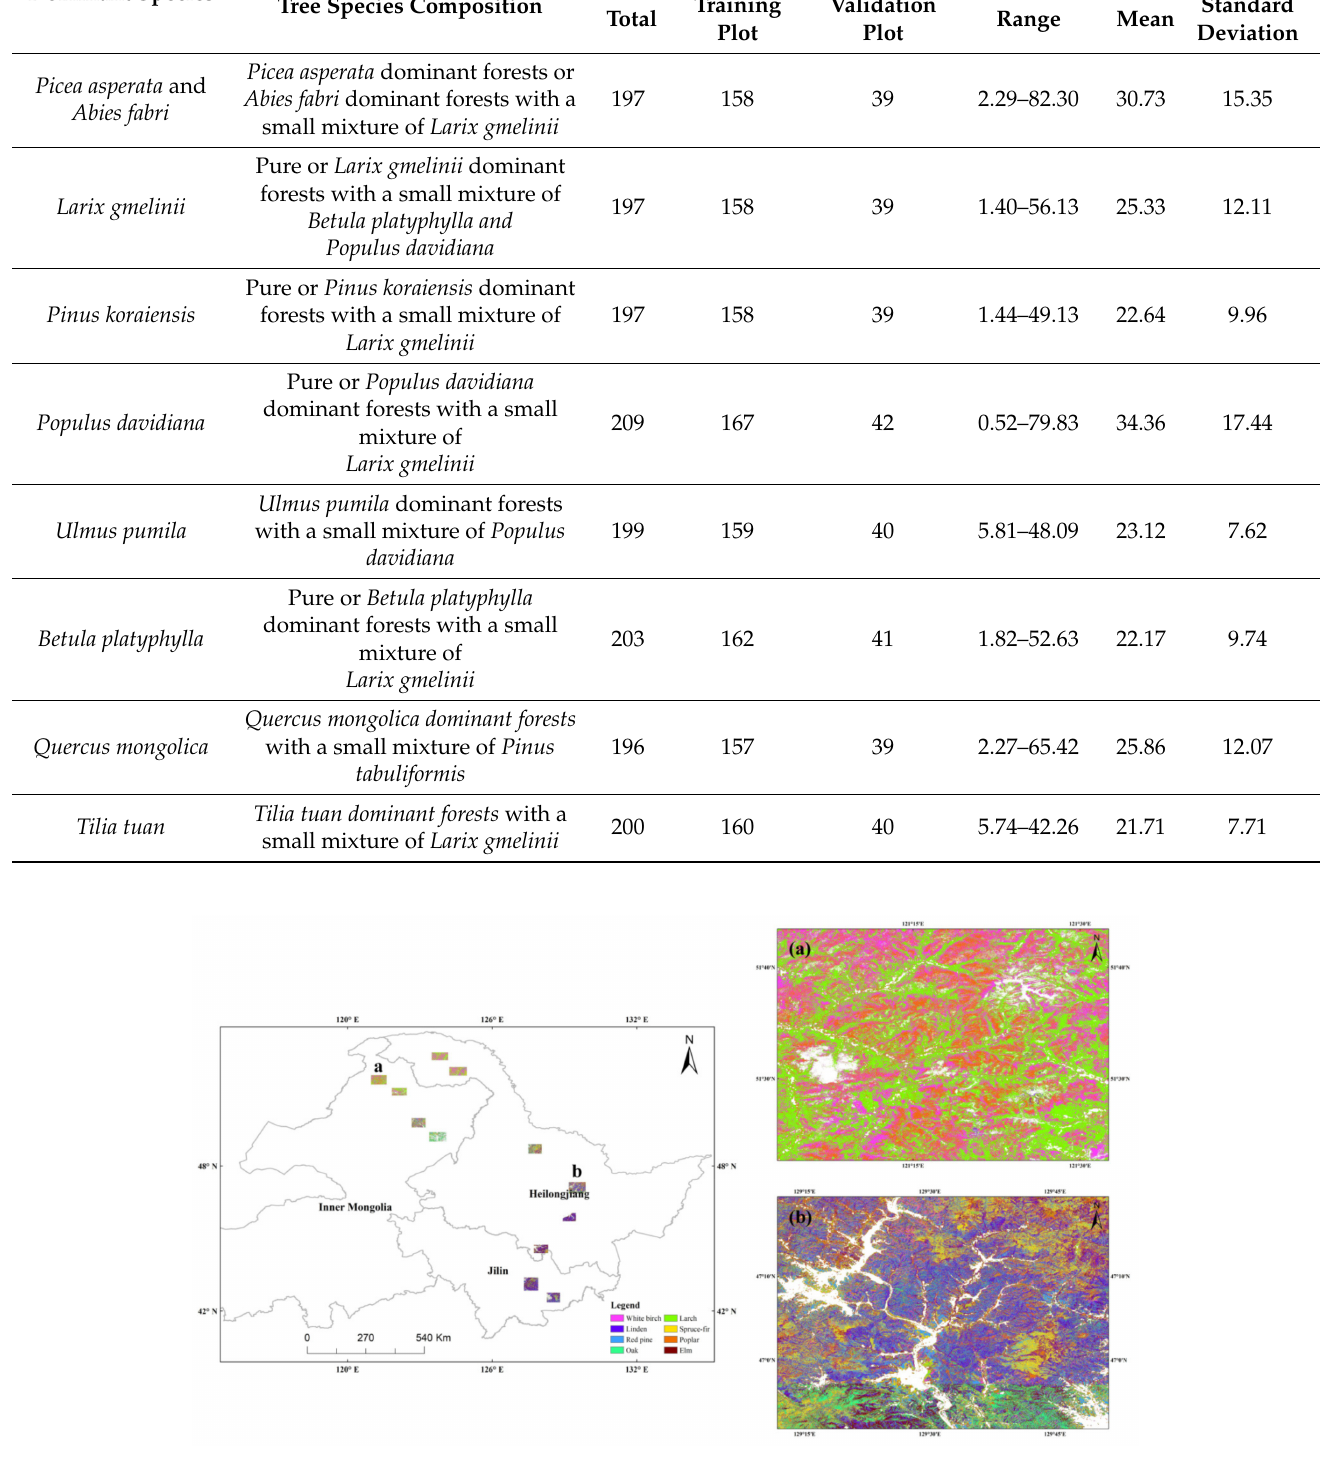
Figure 2. Dominant species map of the study area: ( a , b ) show the spatial distribution of dominant species in two areas at a larger